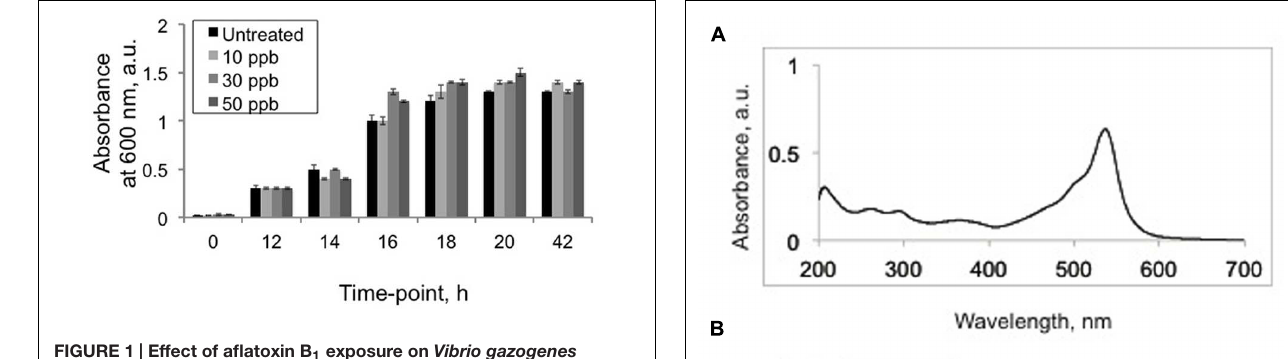
FIGURE 1 | Effect of aflatoxin B 1 exposure on Vibrio gazogenes growth. Growth comparisons were performed using comparisons of 600 nm absorbance values between untreated V. gazogenes cultures and cultures were supplemented with 10, 30, and 50 ppb of aflatoxin B 1 . Statistical significance of two-tailed p -values were determined using an unpaired t -test with sample size of 3 and significance set as p < 0.05.